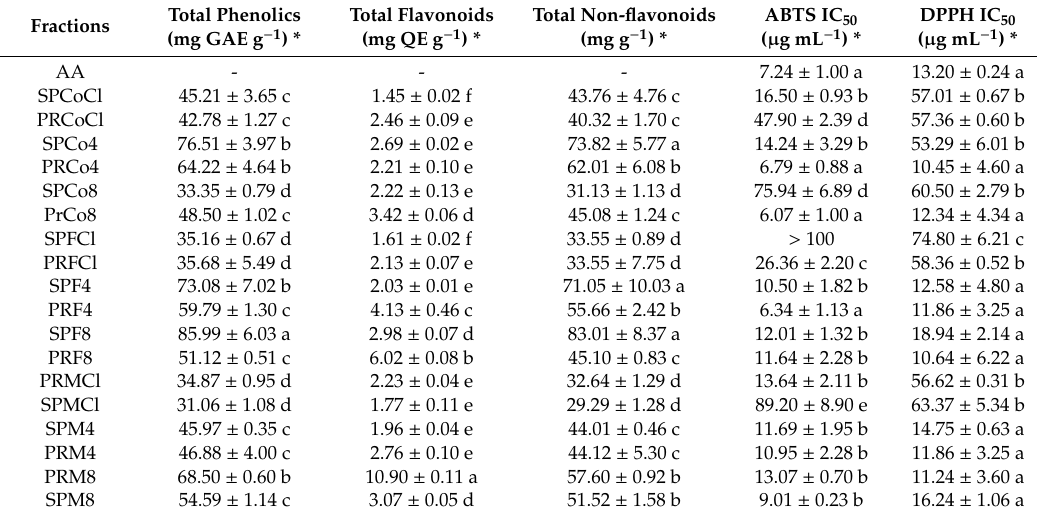
* Data are expressed as mean ± standard deviations (SD) ( n = 3) of experiments performed in triplicate. Averages followed by di ff erent letters di ff er significantly at p < 0.05. GAE = gallic acid equivalent; QE = quercetin equivalent; AA = ascorbic acid; IC 50 = inhibitory concentration. Co = commercial samples, F = female specimens, M = male specimens, SP = S ã o Paulo state, and PR = Paran á state. The presented numbers are related to the pH conditions used to obtain each